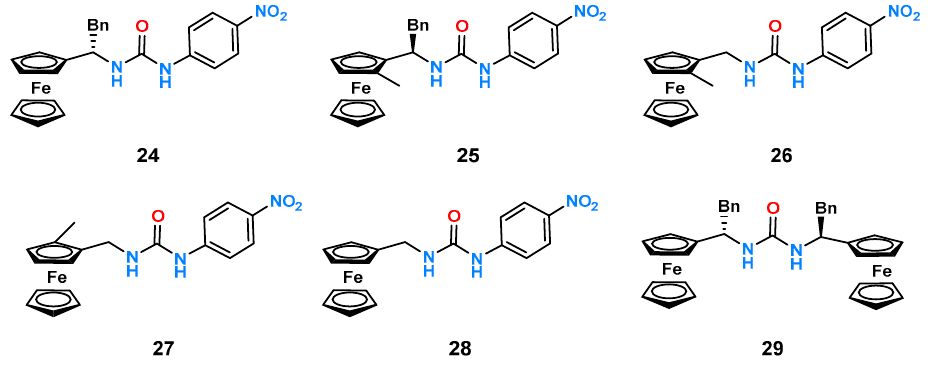
Figure 10. Chiral urea receptors 24–29 containing ferrocene unit.